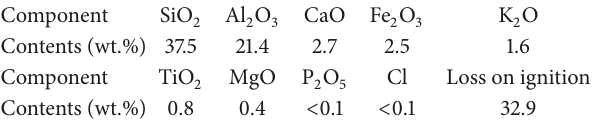
Table 1: Chemical compositions of gangue.